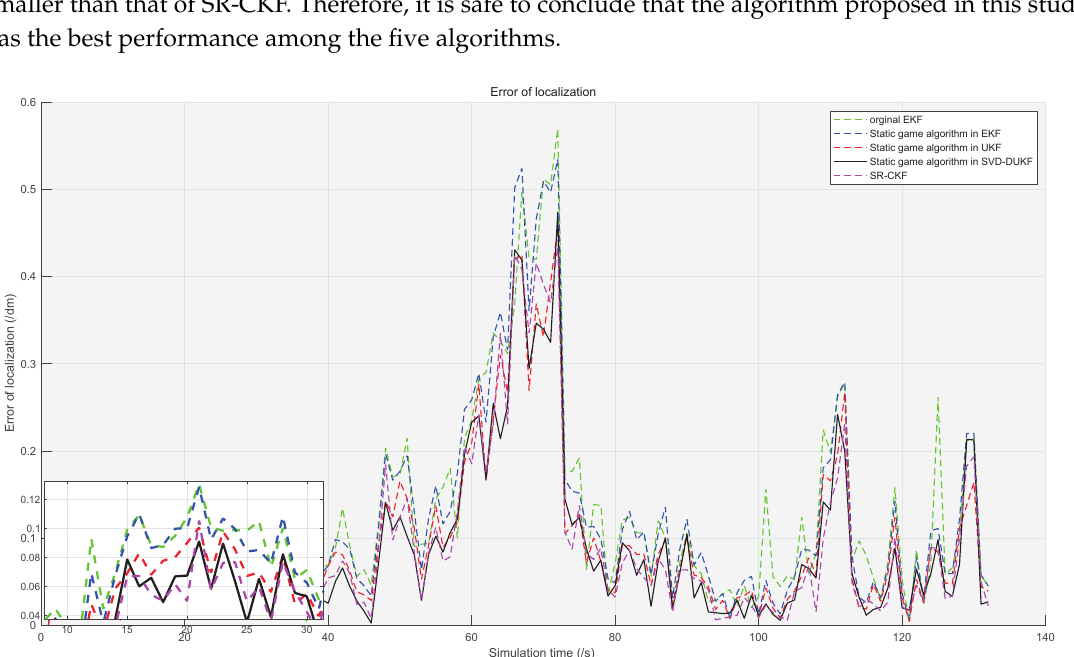
Figure 7. Localization errors of the five algorithms, with the small box in the lower left corner as a partially enlarged view. The control group and the original algorithm are represented by dashed lines in various colors, and the proposed algorithm is represented by the black solid